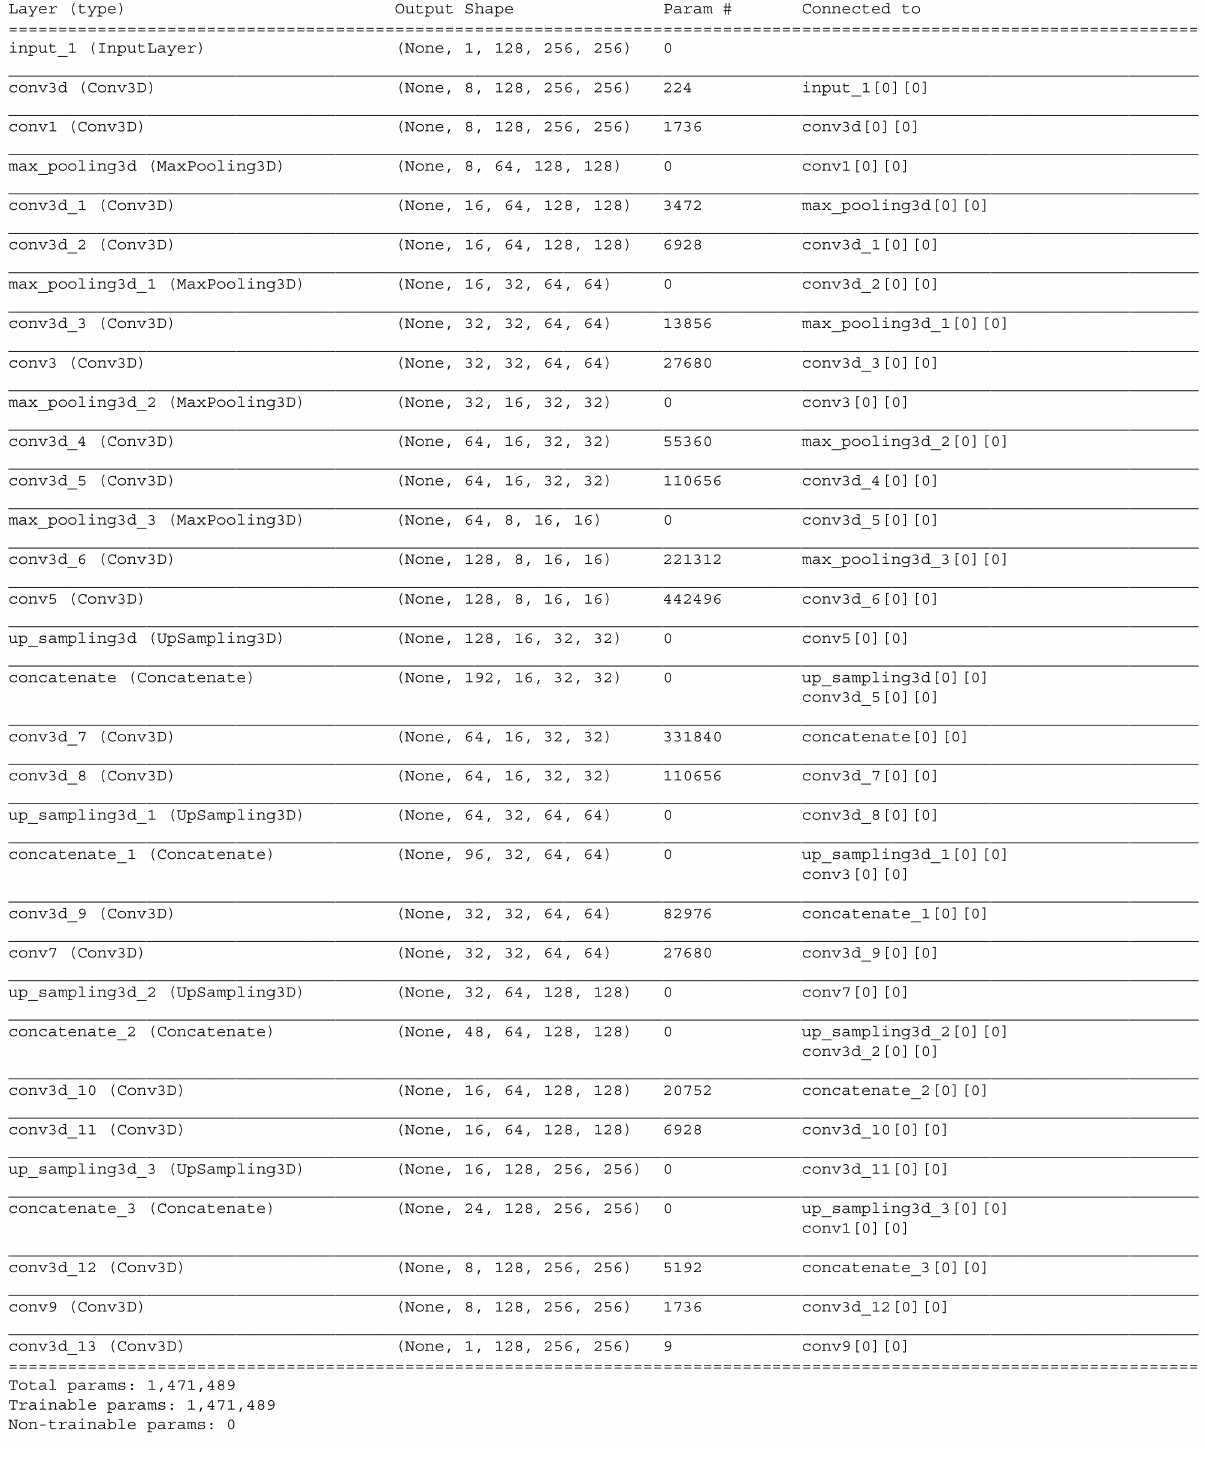
Figure A4. Neural network model summary for Input Size 256 × 256 × 128, Model Reduction